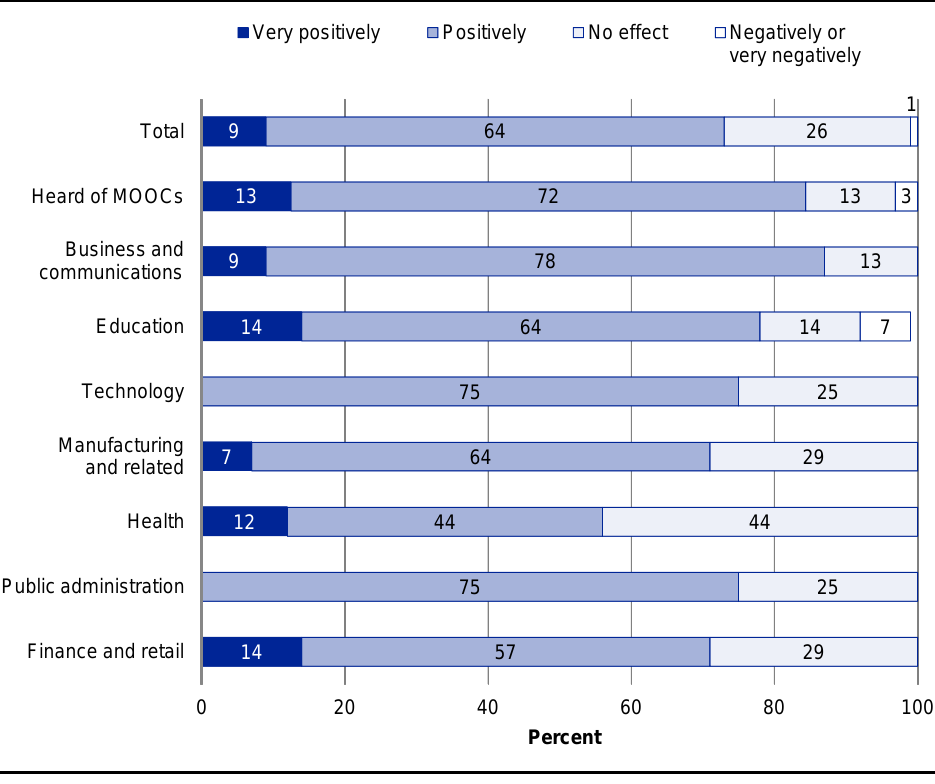
Figure 5. Percentage distribution of organizations that had the following views of MOOC coursetaking in hiring decisions: among all respondents, those that had heard of MOOCs prior to the survey, and by